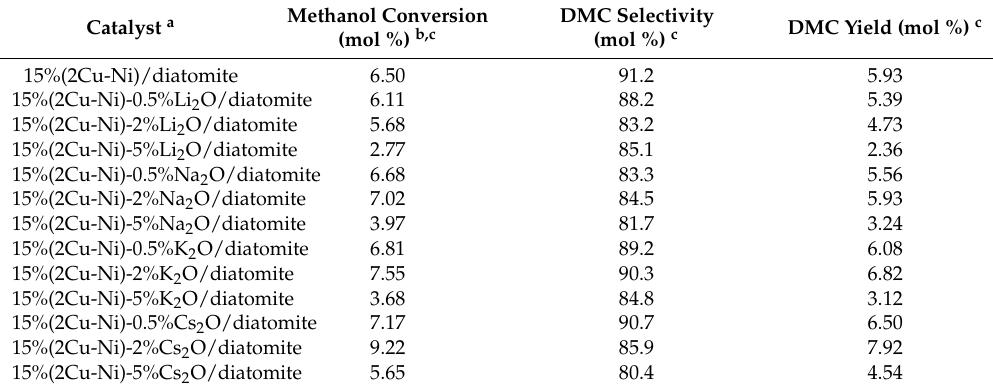
Table 3. Influence of alkali loading on catalytic performance of 15% (2Cu-Ni)/diatomite. Catalyst